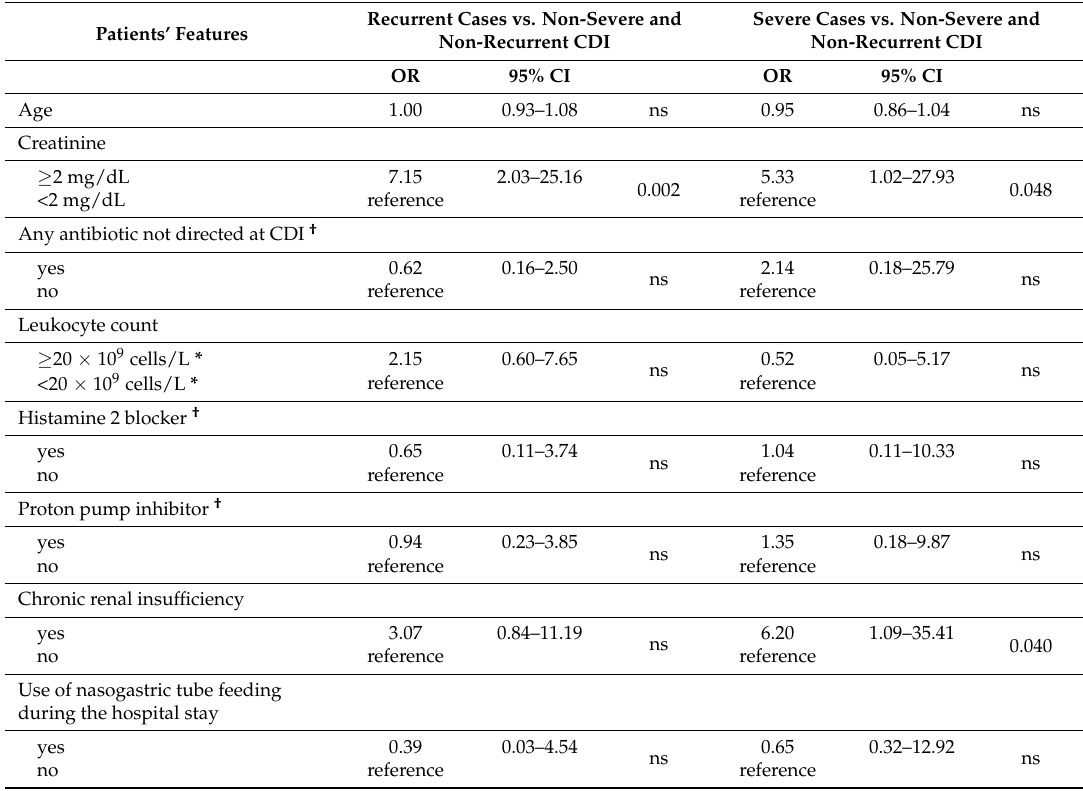
Table 6. Association between severe CDI and recurrent CDI and risk factors: results of multinomial logistic